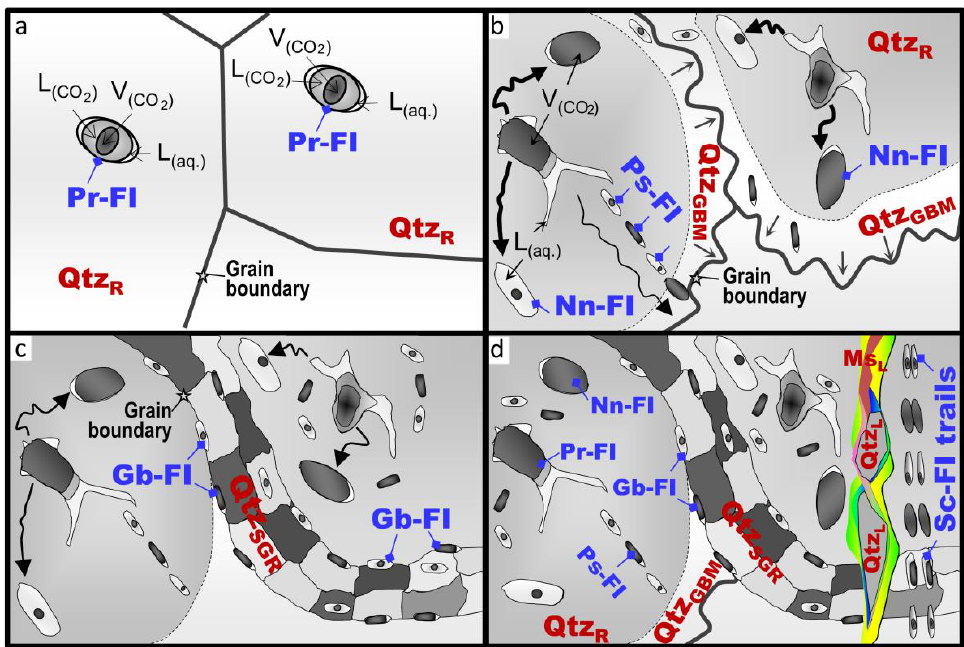
Figure 8. Sketches showing trapping chronologies of FI relative to mineral microstructures ( a – d ). ( a ) Pr-FI trapped within relict quartz grains (Qtz R ) during earliest stages of vein network formation. ( b , c ) Coeval dynamic recrystallization by grain boundary migration (GBM) and sub-grain rotation (SGR); ( b ) shows decrepitated Pr-FI within relict Qtz R grains surrounded by clusters of Nn-FI and trails of Ps-FI, while ( c ) illustrates FI in grain boundaries (Gb-FI). ( d ) Sc-FI crosscutting all microstructures associated to fracturing marked by the occurrence of late muscovite (Ms L ). Minerals 2017 , 7 , x FOR PEER REVIEW